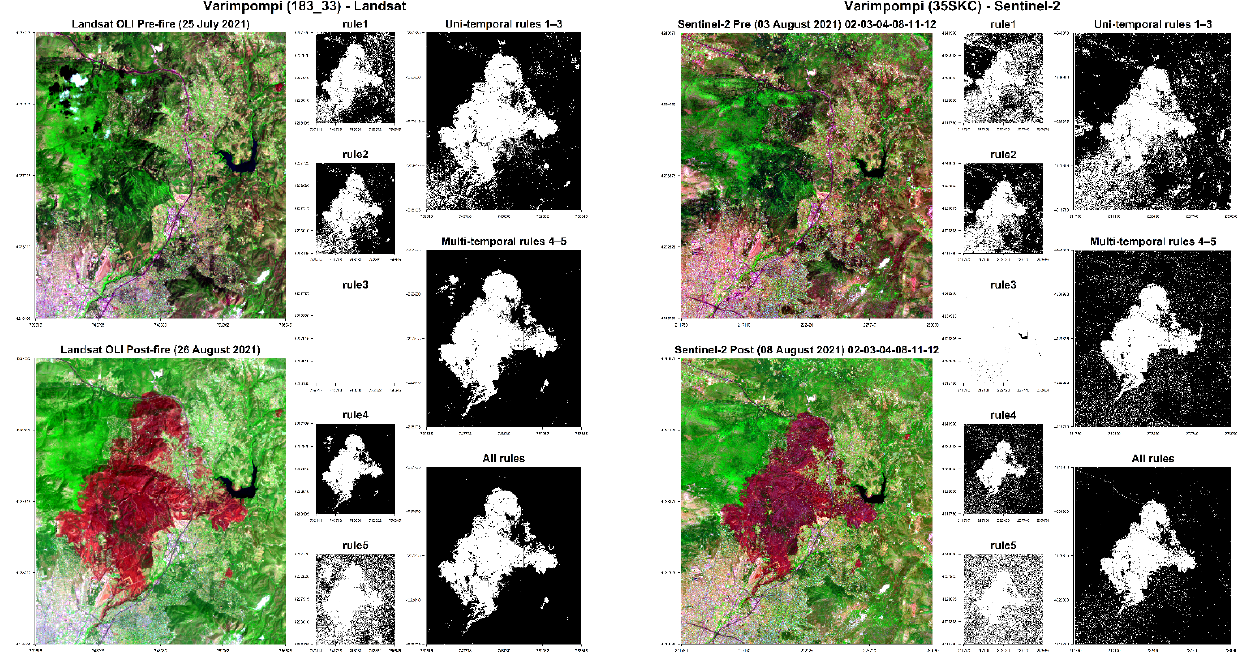
Figure 4. The modified rule-based approach as applied to map a very recent fire that occurred in 2021 in Attica, Greece using both Landsat pre- and post-fire satellite images (left) and Sentinel-2 pre- and post-fire satellite images (right). This is to show that the rule-based approach can also be applied to map the burned areas using Sentinel-2 satellite images.